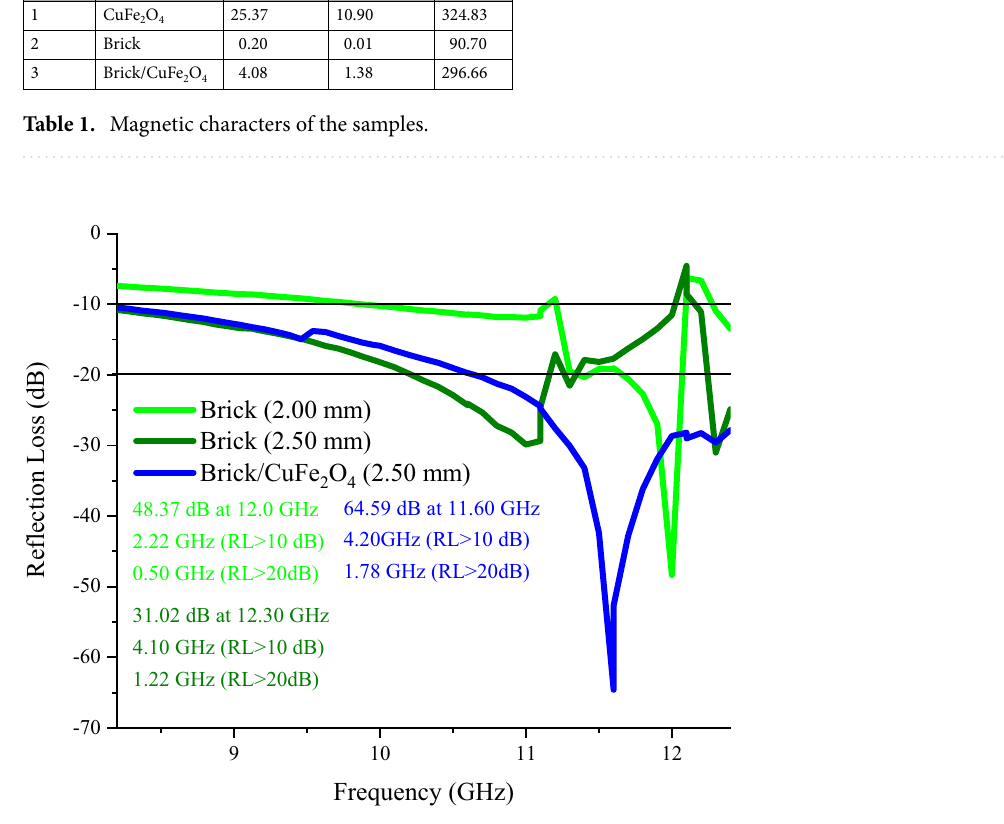
Figure 7. Microwave absorbing features of the